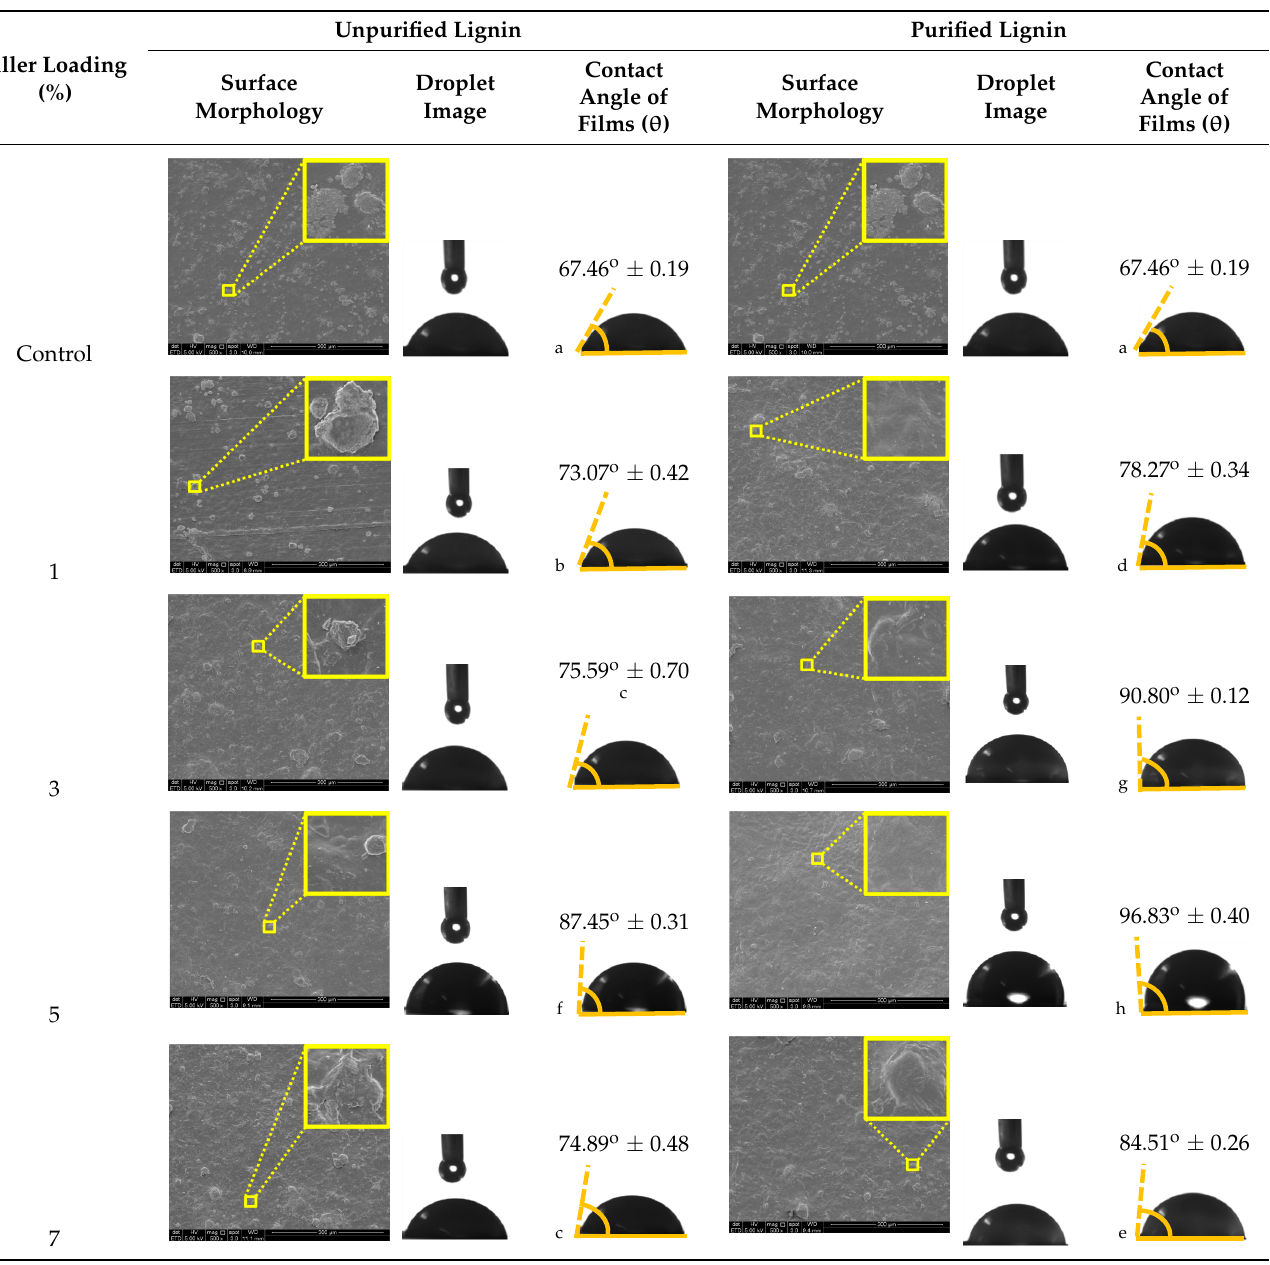
lowed by different superscript letters indicate significant differences ( p <